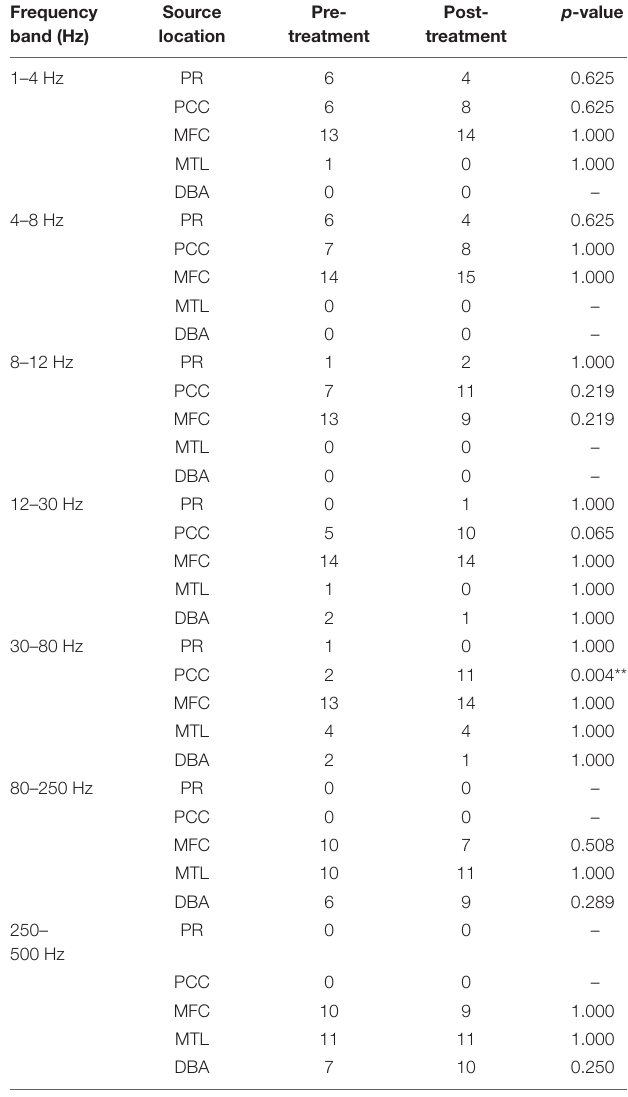
TABLE 3 | Predominant source locations before and after